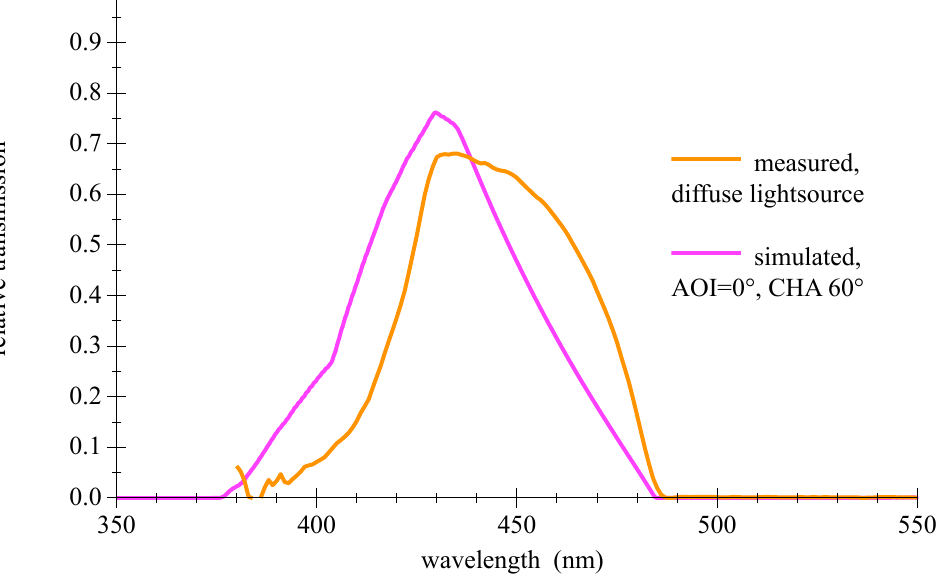
Figure 13. Measured spectral transmission curve for a thin film bandpass filter Semrock 457-50 with diffuse light source and simulated curve for a wide-open cone light source . For further information please refer to the appendix in Appendix